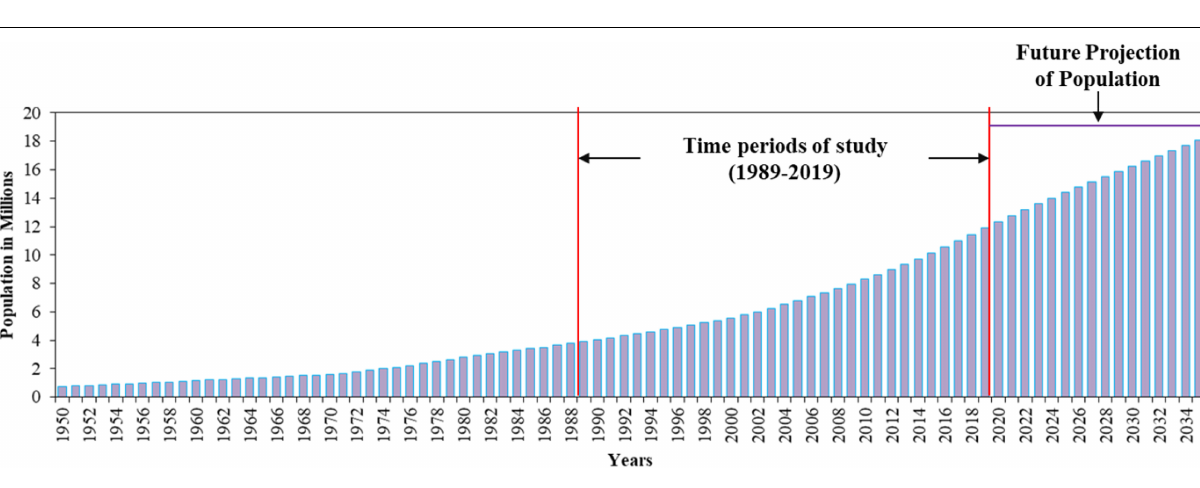
FIGURE 8 | Population of Bengaluru